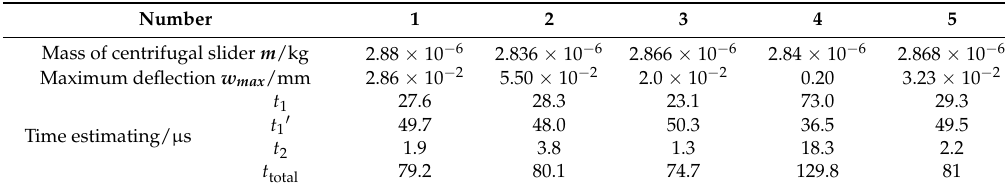
Table 2. The theoretical result of maximum deflection and time estimating.